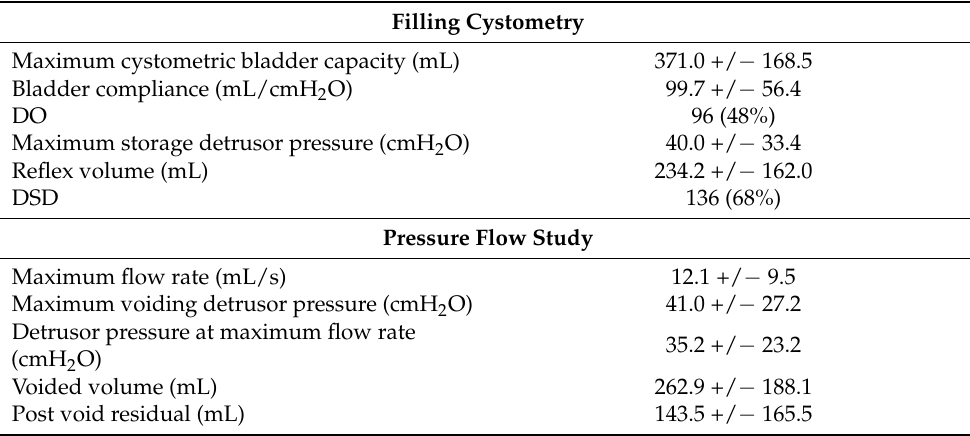
Table 2. Urodynamic parameters.